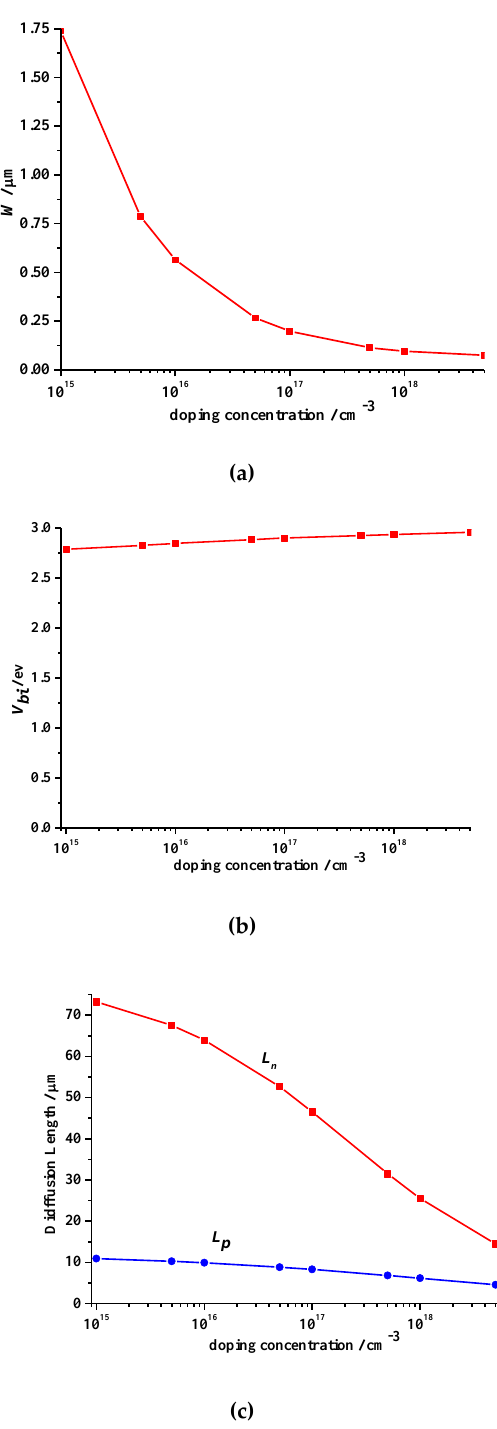
Figure 3. W , V bi and diffusion length of SiC P + N junction.